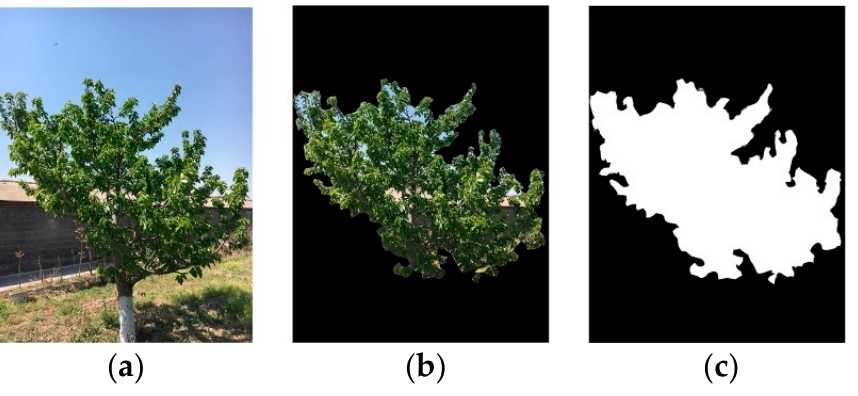
Figure 3. Image annotation schematic: ( a ) original canopy image, ( b ) standard image and ( c ) ground truth image. Figure 4 is a flowchart of the proposed method: feature extraction, Mahalanobis distance computation and conditional random field (CRF) building. All algorithms were developed in MathWorks MATLAB R2018a and Python3.6 software on a PC equipped with an Intel®Core ™ i7-6700 central processing unit (CPU) and 16 GB of random-access memory